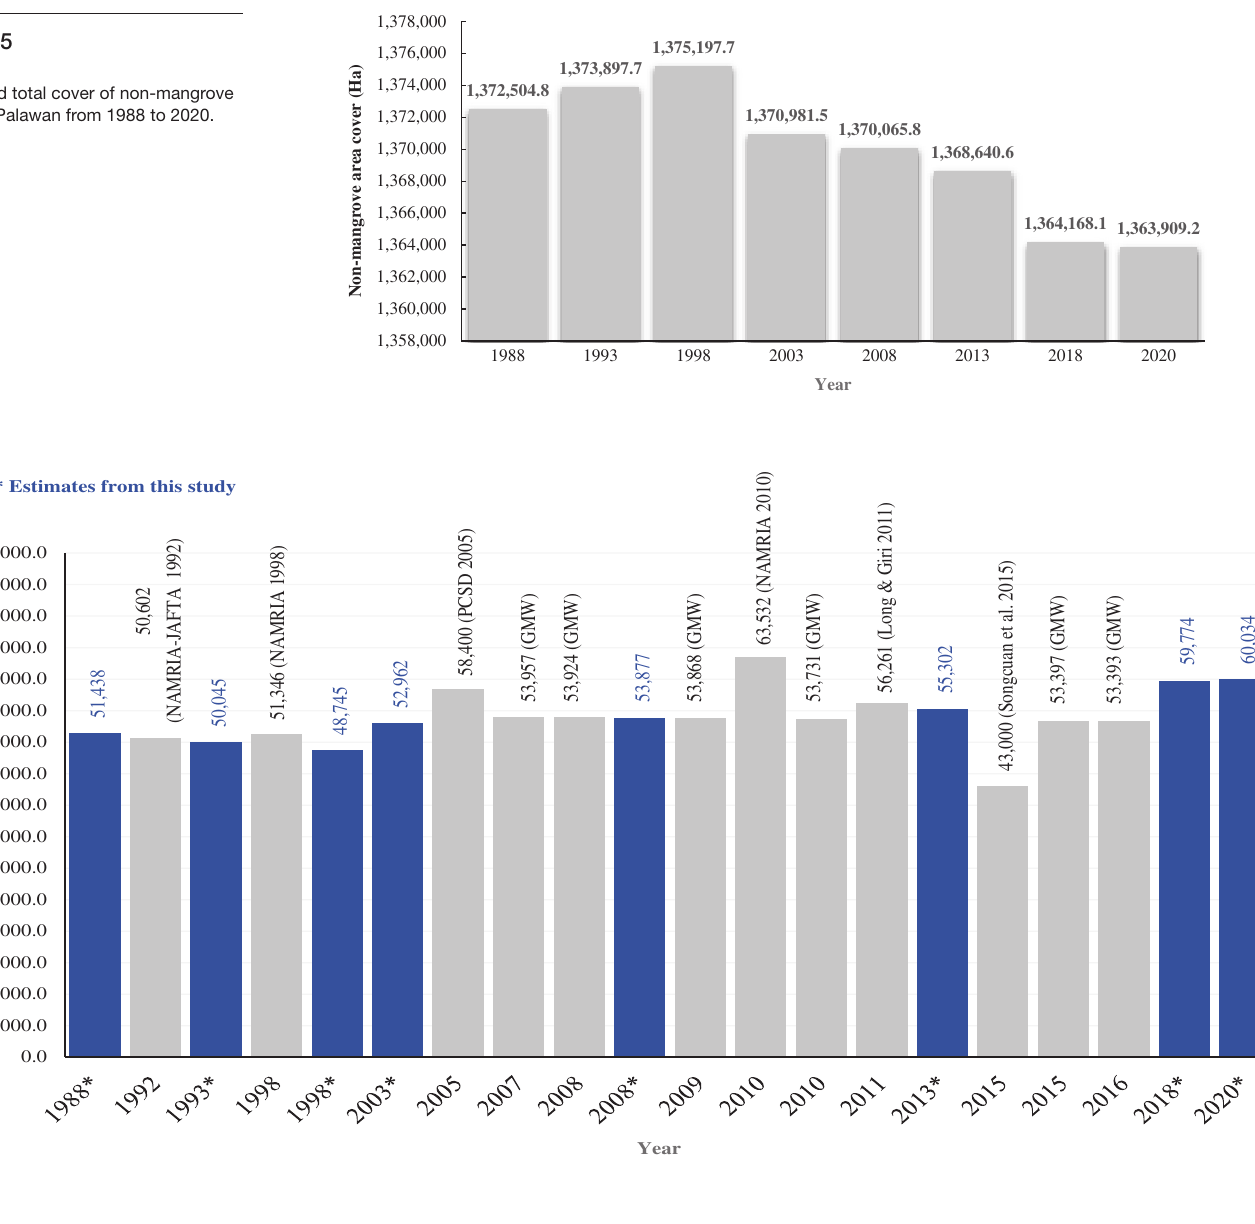
Representation of mangrove forest areas in Palawan based on the previous estimates (grey bars) and the results of this study (blue bars).